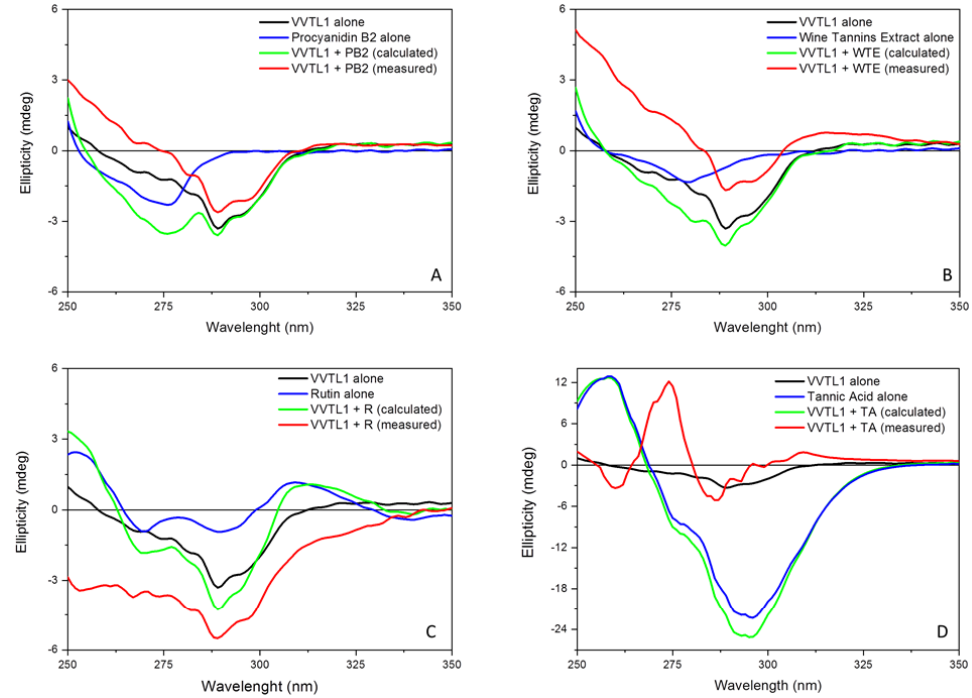
Figure 4. Near-UV CD spectra in MWS of polyphenols alone (blue lines), VVTL1 alone (black lines) and VVTL1 in presence of 2 eq. of selected polyphenols, measured (red lines) or calculated (green lines). Polyphenols were Procyanidin B2 (PB2) ( A ), Wine Tannins Extract (WTE) ( B ), Rutin (R) ( C ), and tannic acid (TA) ( D ). PB1 and Quercetin are not shown as the differences between calculated and measured spectra were equivalent to those shown in ( A ) and ( B ), respectively. VVTL1 concentration was 0.500 mg/mL. The CD spectra were measured using nitrogen flushed Jasco J-715 spectropolarimeter, scanning speed 50 nm/min., data pitch 0.5 nm, response time 4 s, bandwidth 2 nm using a Suprasil 1.0 cm cell (Hellma) that was filled with 900 µL of solution.